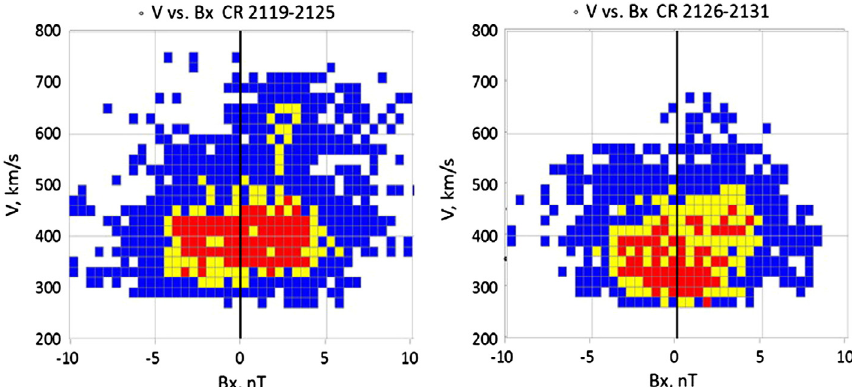
Figure 5. Scatter plot of hourly values of the SW velocity versus the Bx -component of IMF during CR 2119–2125 (left) and CR 2126–2131 (right). The blue bars correspond to the counts less than 10, the yellow bars – from 10 to 20 and the red bars – more